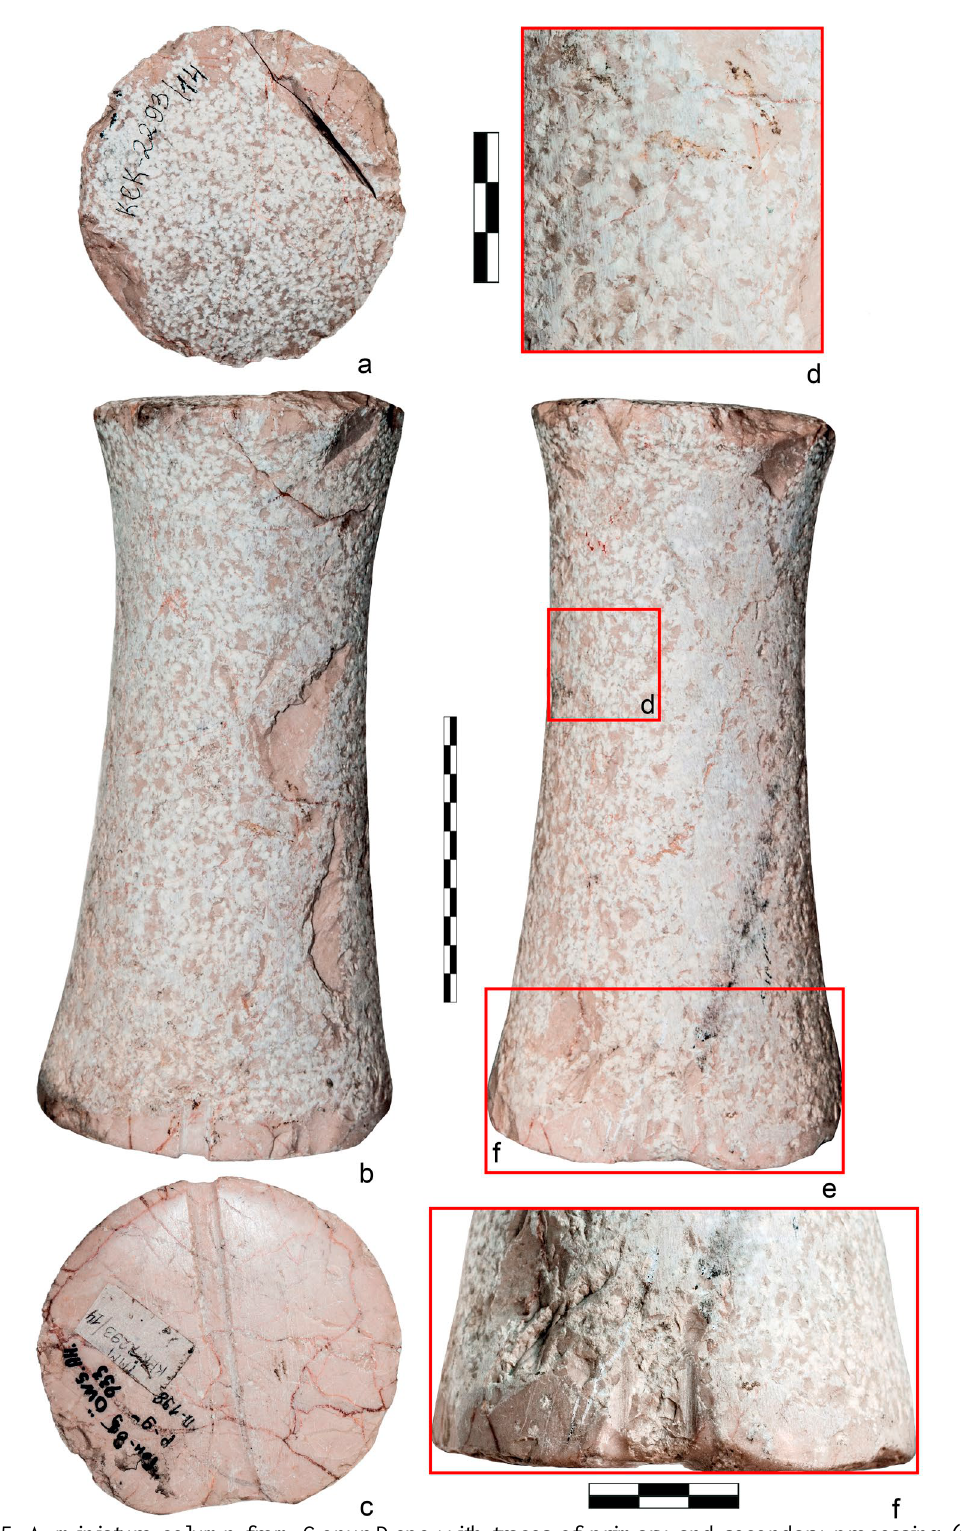
Figure 15. A miniature column from Gonur Depe with traces of primary and secondary processing (from the depositories of the National Museum of Turkmenistan, Ashgabat): a. top base with traces of percussion and pecking; b, e. side; c. bottom base with traces of polishing; d. traces of pecking; f. groove sawing traces. Scale bar for a a, d and f is 3 cm long, and for b, c, and e, is 10 cm long, both separated into 1 cm